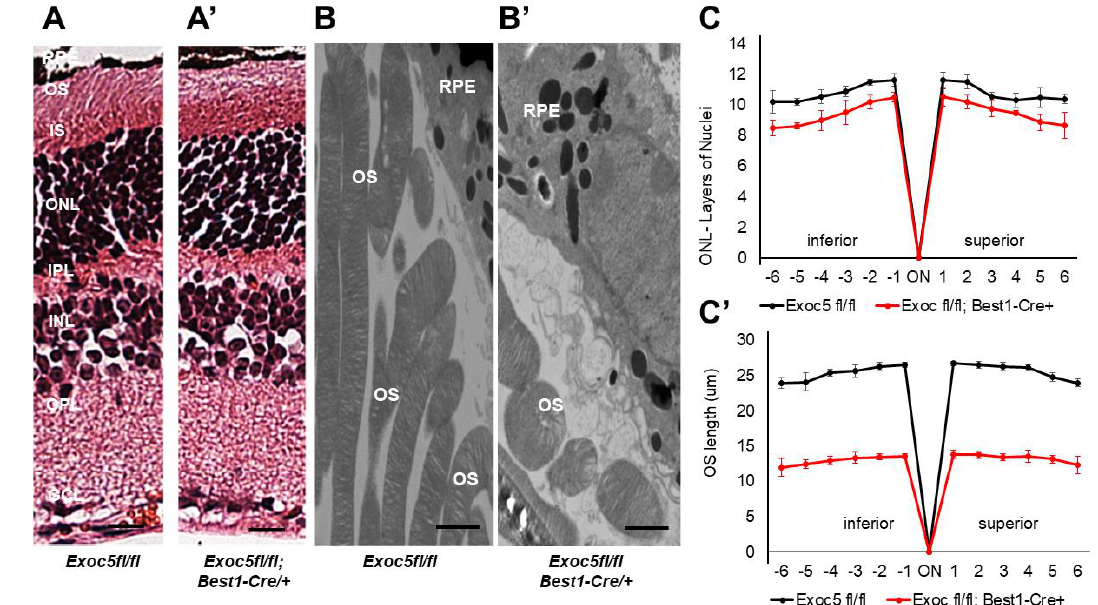
Figure 5. Histological and TEM analysis of retinas of Exoc5 −/− mutants and WT mice at 27 weeks of age. ( A, A’ ) H&E staining of WT and Exoc5 −/− retinas at 27 weeks suggests the presence of disorganized rod outer segments (OS). ( B, B’ ) Transmission electron microscopy of WT and Exoc5 −/− photoreceptor cells reveal packages of rod OS in the subretinal space. ( C , C’ ) Thickness of the ONL ( C ) and OS lengths ( C’ ) from H&E sections through the optic nerve (ON; 0 μ m distance from Optic Nerve and starting point) was measured at 12 locations around the retina, six each in the superior and inferior hemispheres, each equally at 150 μ m distances. Scale bars = 800 nm ( B, B’ ). OS, outer segments; RPE, retinal pigmented epithelium; IS, inner segments; ONL, outer nuclear layer; INL, inner nuclear layer; OPL, outer plexiform layer.